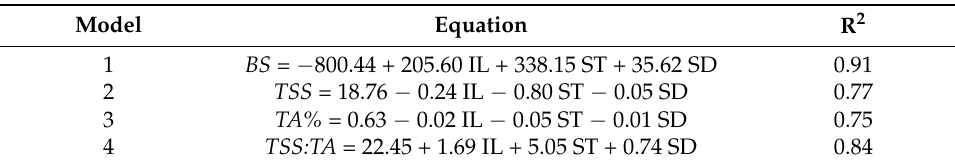
Table 4. Linear regression equations of dependent variables (bruise susceptibility ( BS ), total soluble solids ( TSS ), titratable acidity ( TA% ), and sugar:acid ratio ( TSS:TA )) in relation to the independent variables, which include impact level (IL), storage temperature (ST), and storage duration (SD).